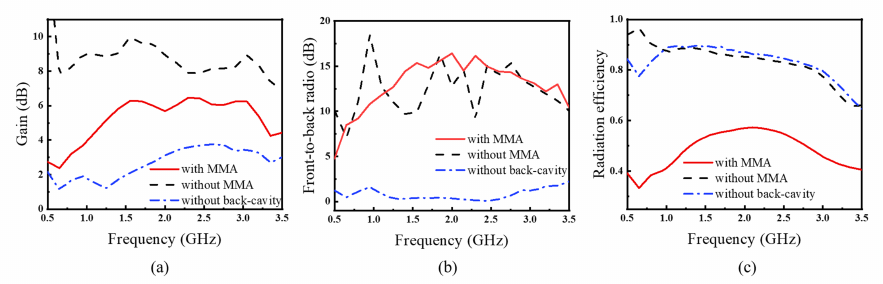
Figure 5. The simulated ( a ) gain, ( b ) front-to-back ratio and ( c ) radiation efficiency of the transceiver